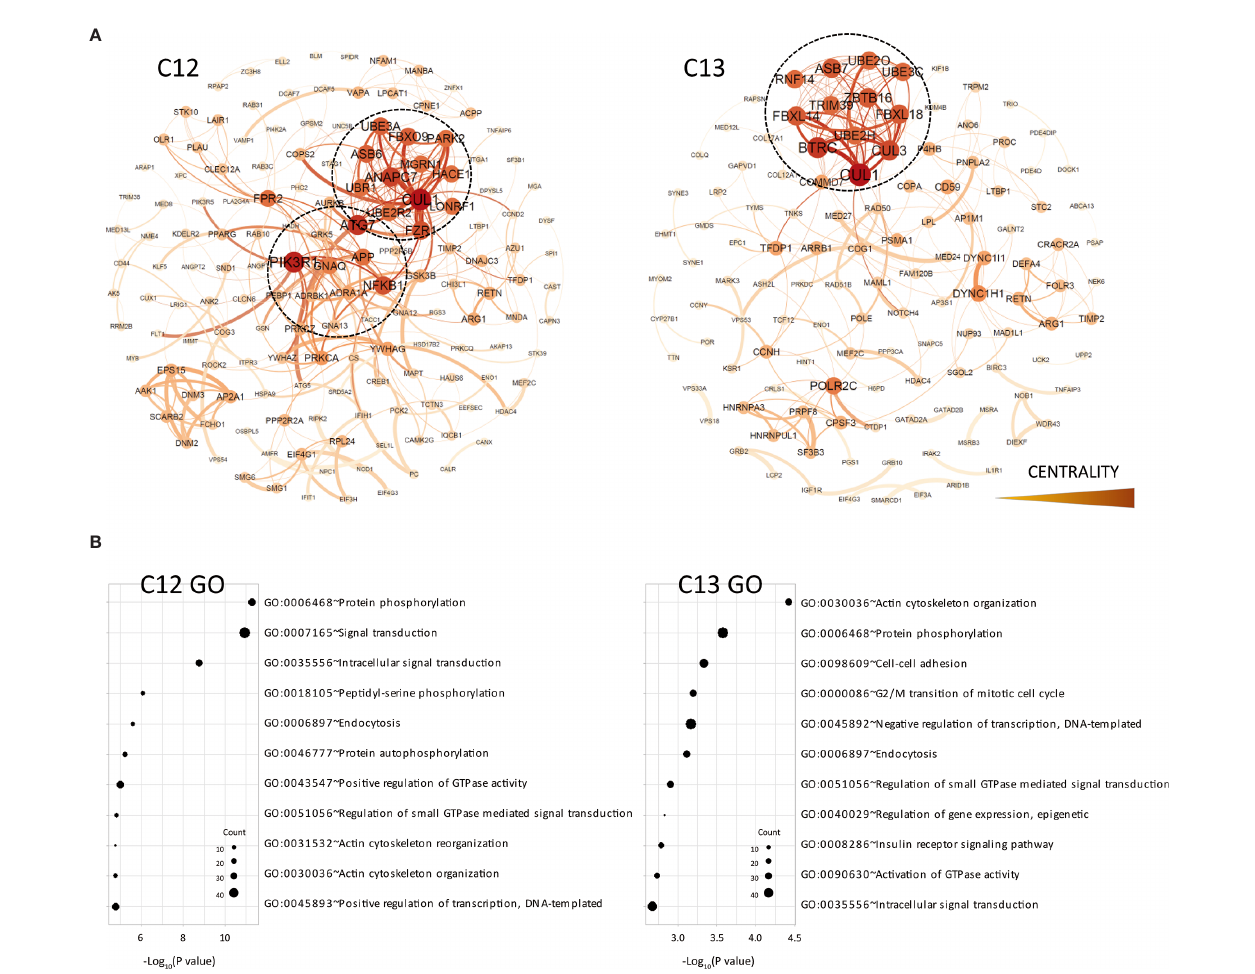
FIGURE 3 | Functional analysis of clusters C12 and C13. (A) Functional interaction networks derived from co-methylated clusters (C12 and C3) obtained from WGCNA analysis, corresponding to DMRs hypomethylated in the CR group. (B) Gene ontology analysis of clusters C12 and